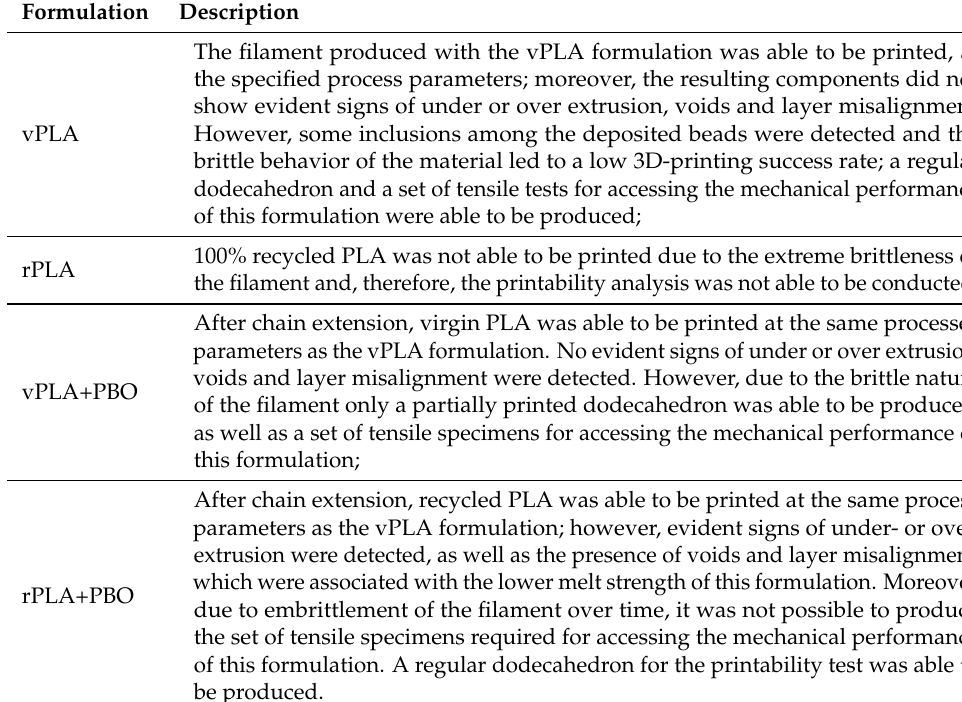
Table 5. Qualitative analysis of the print quality of the formulations of each recycling chain by addressing the success of the print, under- or over-extrusion, presence of voids and bubbles and layer